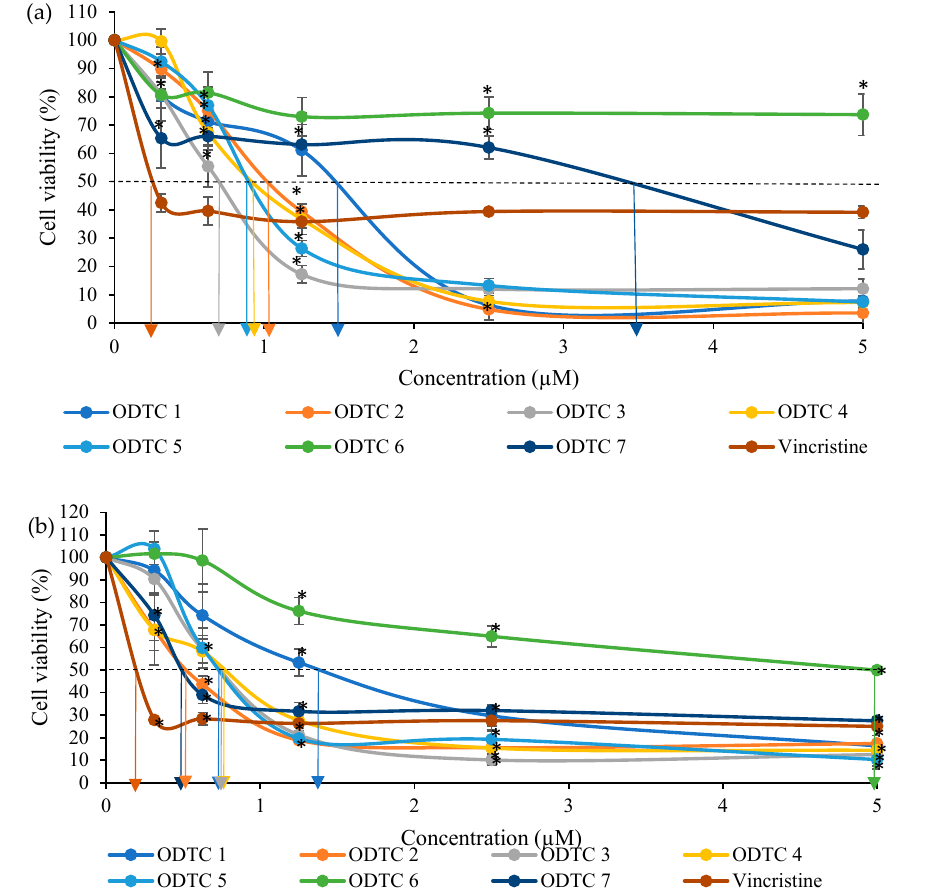
Figure 2. Cytotoxic effects of diphenyltin(IV) diisopropyl dithiocarbamate (ODTC 1), diphenyltin(IV) diallyl dithiocarbamate (ODTC 2), triphenyltin(IV) diisopropyl dithiocarbamate (ODTC 3), triphenyltin(IV) diallyl dithiocarbamate (ODTC 4), triphenyltin(IV) diethyl dithiocarbamate (ODTC 5), dimethyltin(IV) diisopropyl dithiocarbamate (ODTC 6) and dimethyltin(IV) diethyl dithiocarbamate (ODTC 7) towards ( a ) Jurkat E6.1 and ( b ) WIL2-NS cell line after 24 h of exposure. The IC 50 values obtained are as shown in the graph above. The data presented are the mean percentage of viable cells (%) ± SEM obtained from three different experiments (n = 3). * Significant difference ( p < 0.05) from the negative control. Table 1. The IC 50 values of organotin(IV) dithiocarbamate compounds and vincristine against Jurkat E6.1